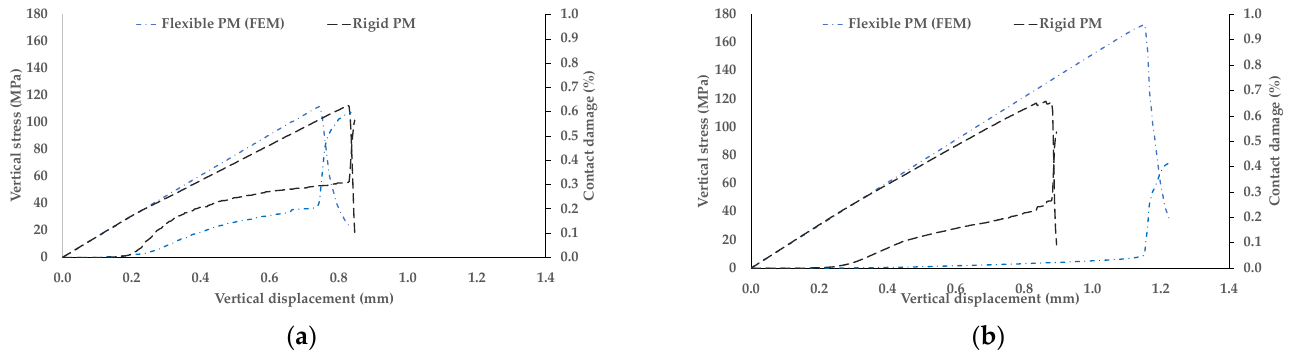
Figure 9. Axial stress–displacement response under uniaxial compression–proposed flexible PM models and rigid PM model: ( a ) brittle model; ( b ) bilinear softening model. Table 4. Execution times (hours) for the completion of 1,000,000 calculation cycles. Model